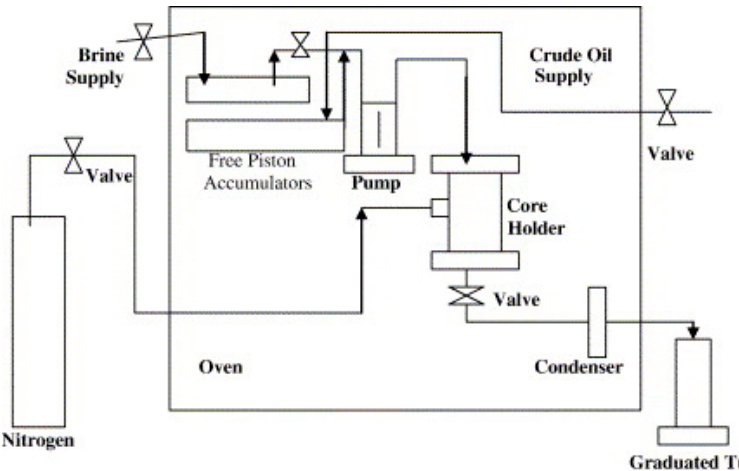
Figure 9. The scheme of a traditional core flooding experiment, reproduced with permission from [82]; copyright Elsevier, 2006.